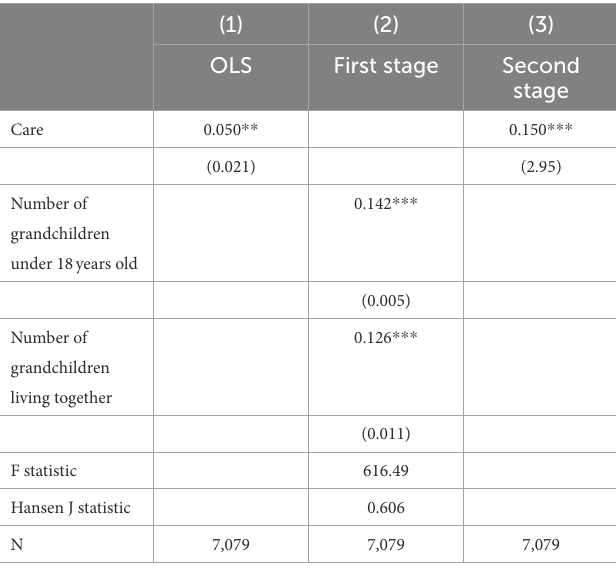
TABLE 3 Endogeneity